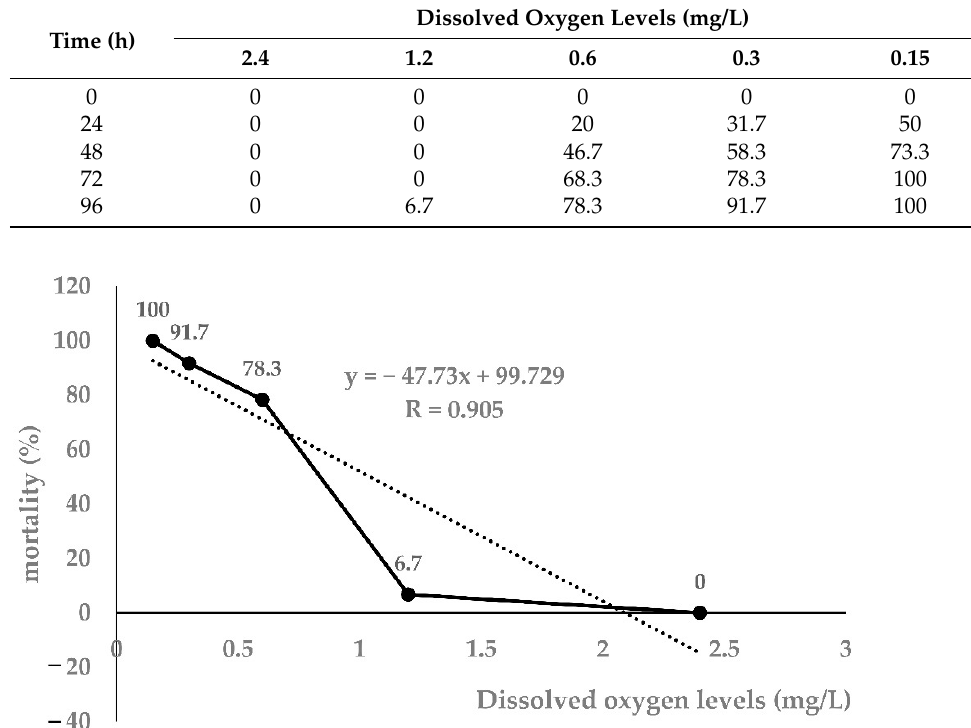
Figure 1. Linear interpolation graph for 96h-LH 50 ( n = 20).